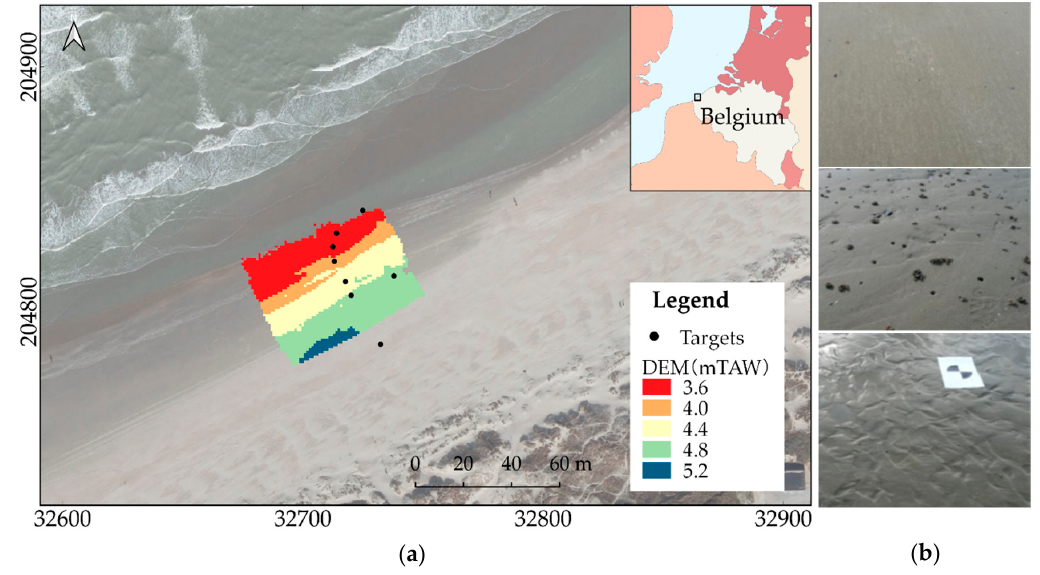
Figure 8. ( a ) Study site at the beach of Groenendijk and DEM of a 40 × 50 m area scanned three times. The black points denote the positioning targets. The photos in ( b ) represent three main morphologies on the measurement beach: flat surface, flat surface with razor shell dumps and flat surface with ripples.